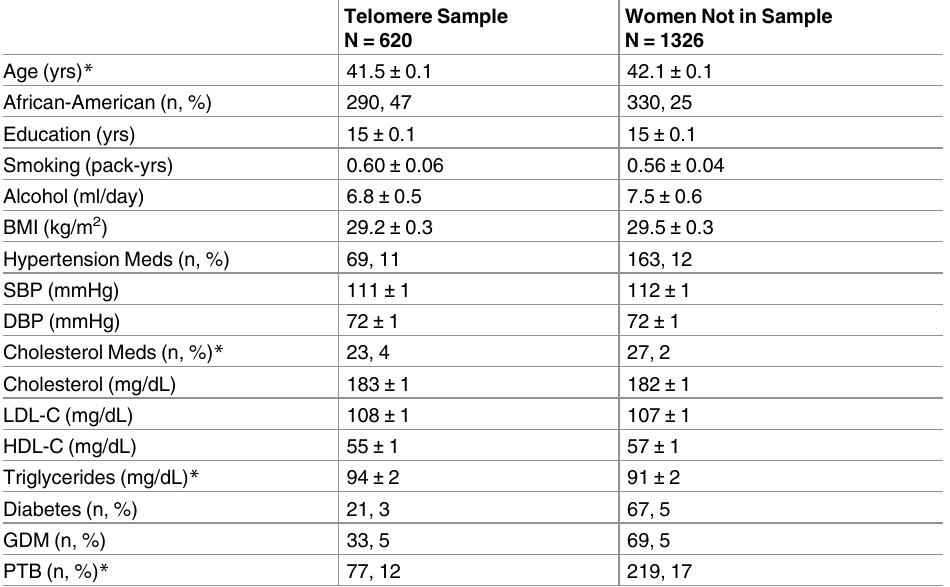
Table 1. Participant characteristics compared women not in